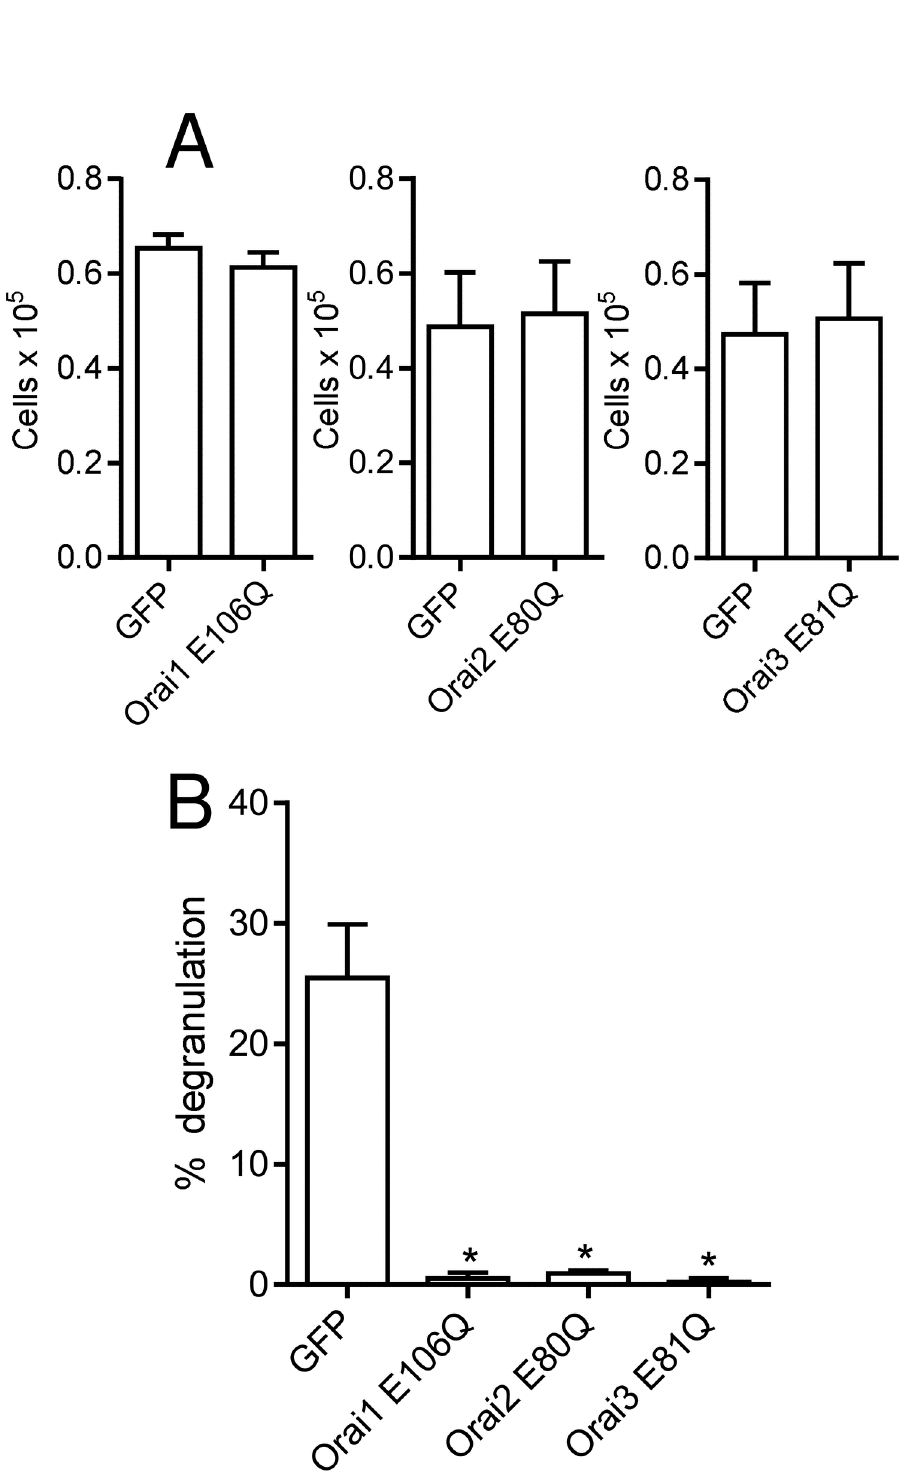
Figure 4. The effect of dominant negative mutations of Orai1 (E106Q), Orai2 (E80Q) and Orai3 (E81Q) on HLMC degranulation. ( A ) Transduction of HLMCs with Orai dominant-negative mutants had no effect on cell viability after 4 days compared to GFP control virus (n=5). ( B ) β-hexosaminidase degranulation was essentially abolished following transduction of HLMC with Orai dominant negative mutants. Mean ± SEM of net percentage release observed in cells transduced with adenoviruses expressing the indicated protein. n=4-7, * p<0.05 compared to GFP control. doi: 10.1371/journal.pone.0074895.g004 PLOS ONE |